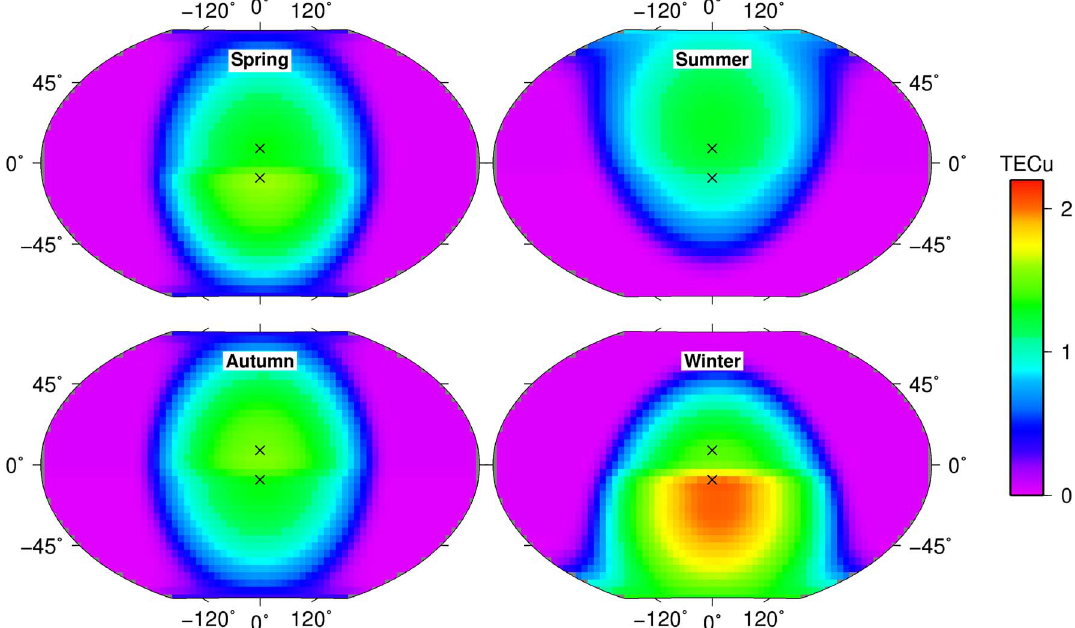
Fig. 8. Global maps of Mars vTEC. The different maps correspond to the different outputs of the MoMo model for different seasons (in the North hemisphere) at local noon at the meridian origin. The F10.7P is fi xed for a high solar activity level (170 sfu) corresponding to F 10 : 7 P of 70 sfu for spring, 61 sfu for summer, 79 sfu for autumn and 88 sfu for winter. The black crosses are the location of two assets on the Mars surface (N10 (cid:3) and S10 (cid:3) in latitude; 0 (cid:3) in longitude) used in Figures 9 and 10.